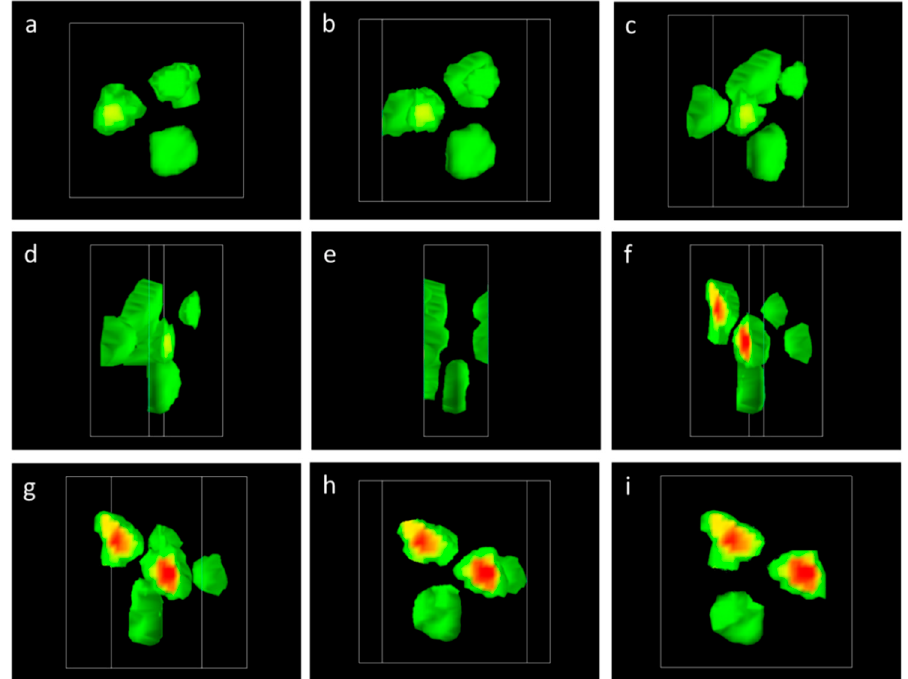
Figure 11. ( a – i ) Consecutive shots of the reconstructed image of the off-resonant attenuation (gamma-CT image) captured from the visualized three-dimensional movie.